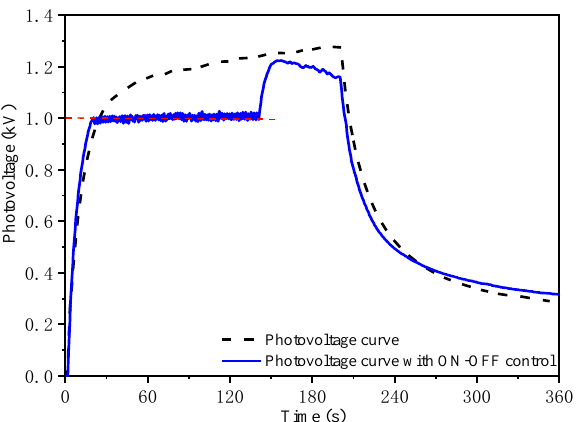
Figure 20. Comparison of photovoltage curves under irradiation of 50 mW/cm 2 between controlled and uncontrolled photovoltage.